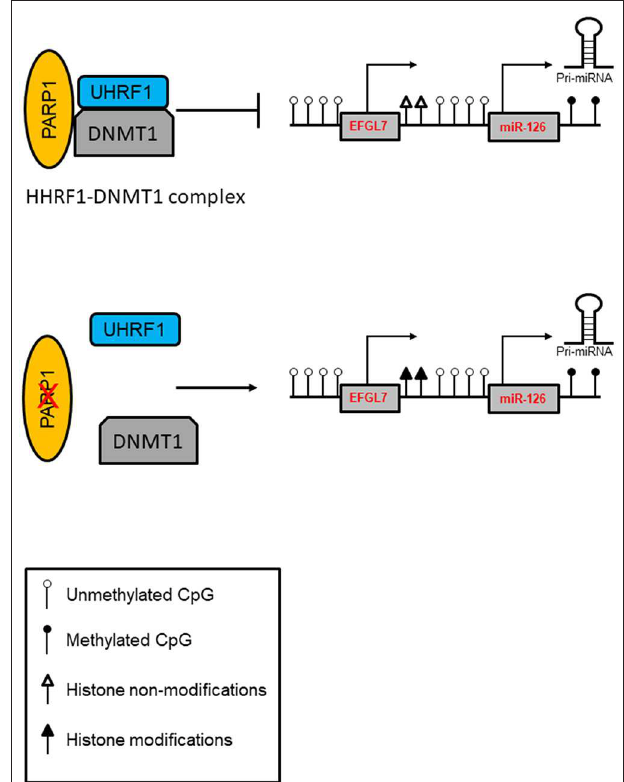
FIGURE 2 | Model of PARP1-mediated control of chromatin structure in the regulation of miRNA expression. PARP1 promotes the interaction of UHRF1 with DNMT1 in regulating miRNA expression independently of DNA methylation. In addition, PARP1 activation facilitates the demethylation of DNA by the recruitment of TET1 and by the exclusion of DNMT1. Inhibition of PARP1 reduces the interaction of the UHRF1-DNMT1 complex that regulates chromatin condensation and enhances